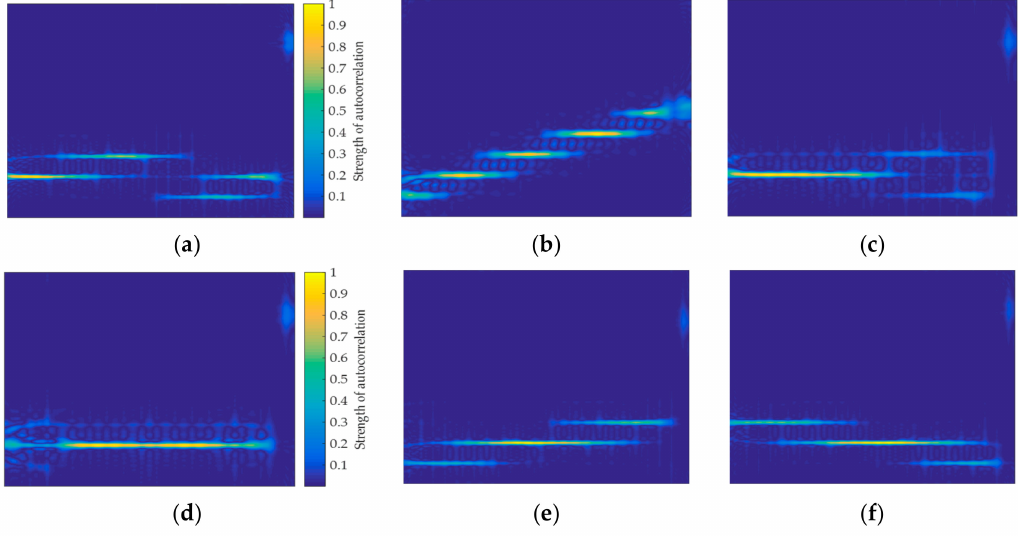
Figure 9. Short-time autocorrelation images of six signals: ( a ) Frank; ( b ) LFM; ( c ) T1; ( d ) T2; ( e ) P1; and, ( f )